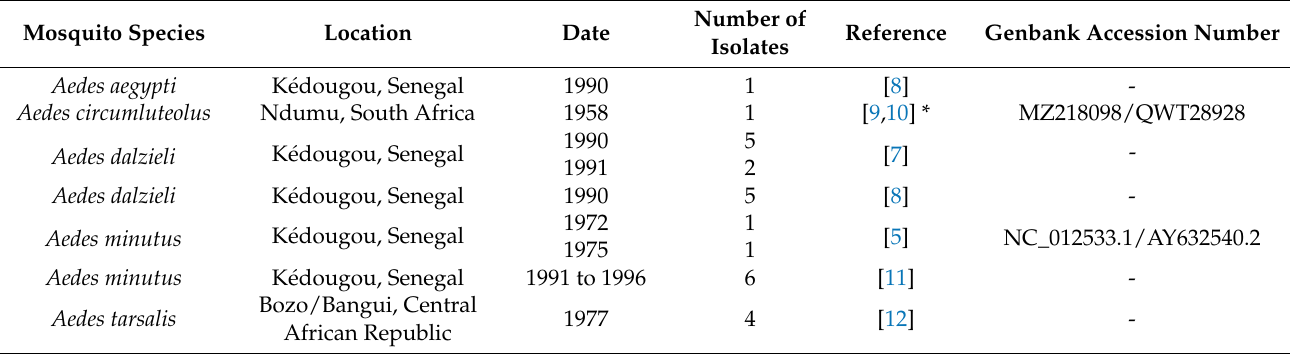
Table 2. Mosquito isolates of KEDV between